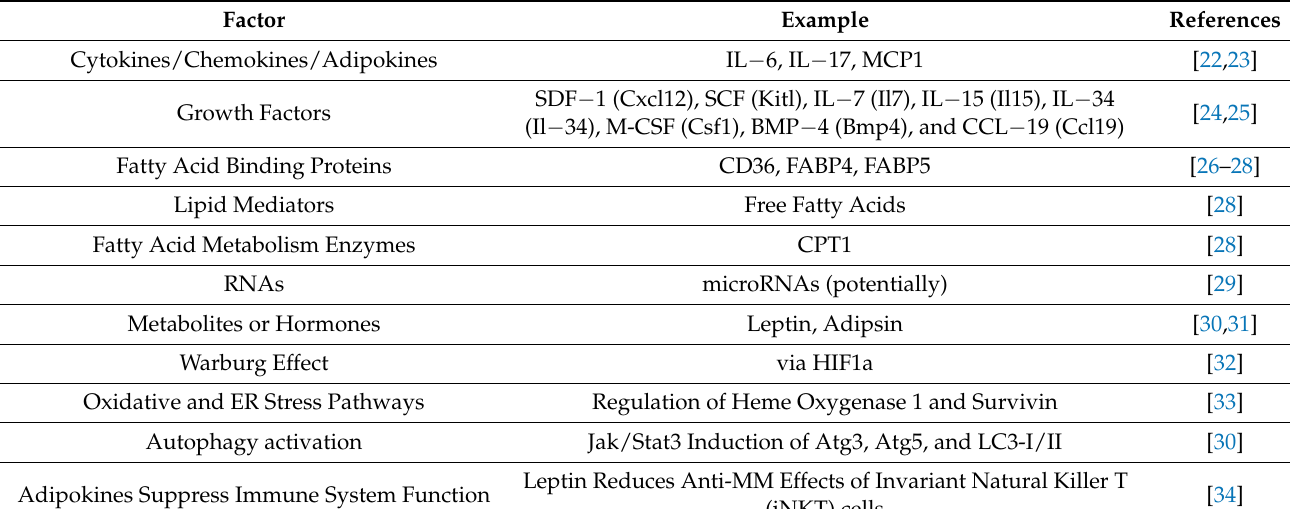
Table 1. Factors and mechanisms through which tumor cells are affected by